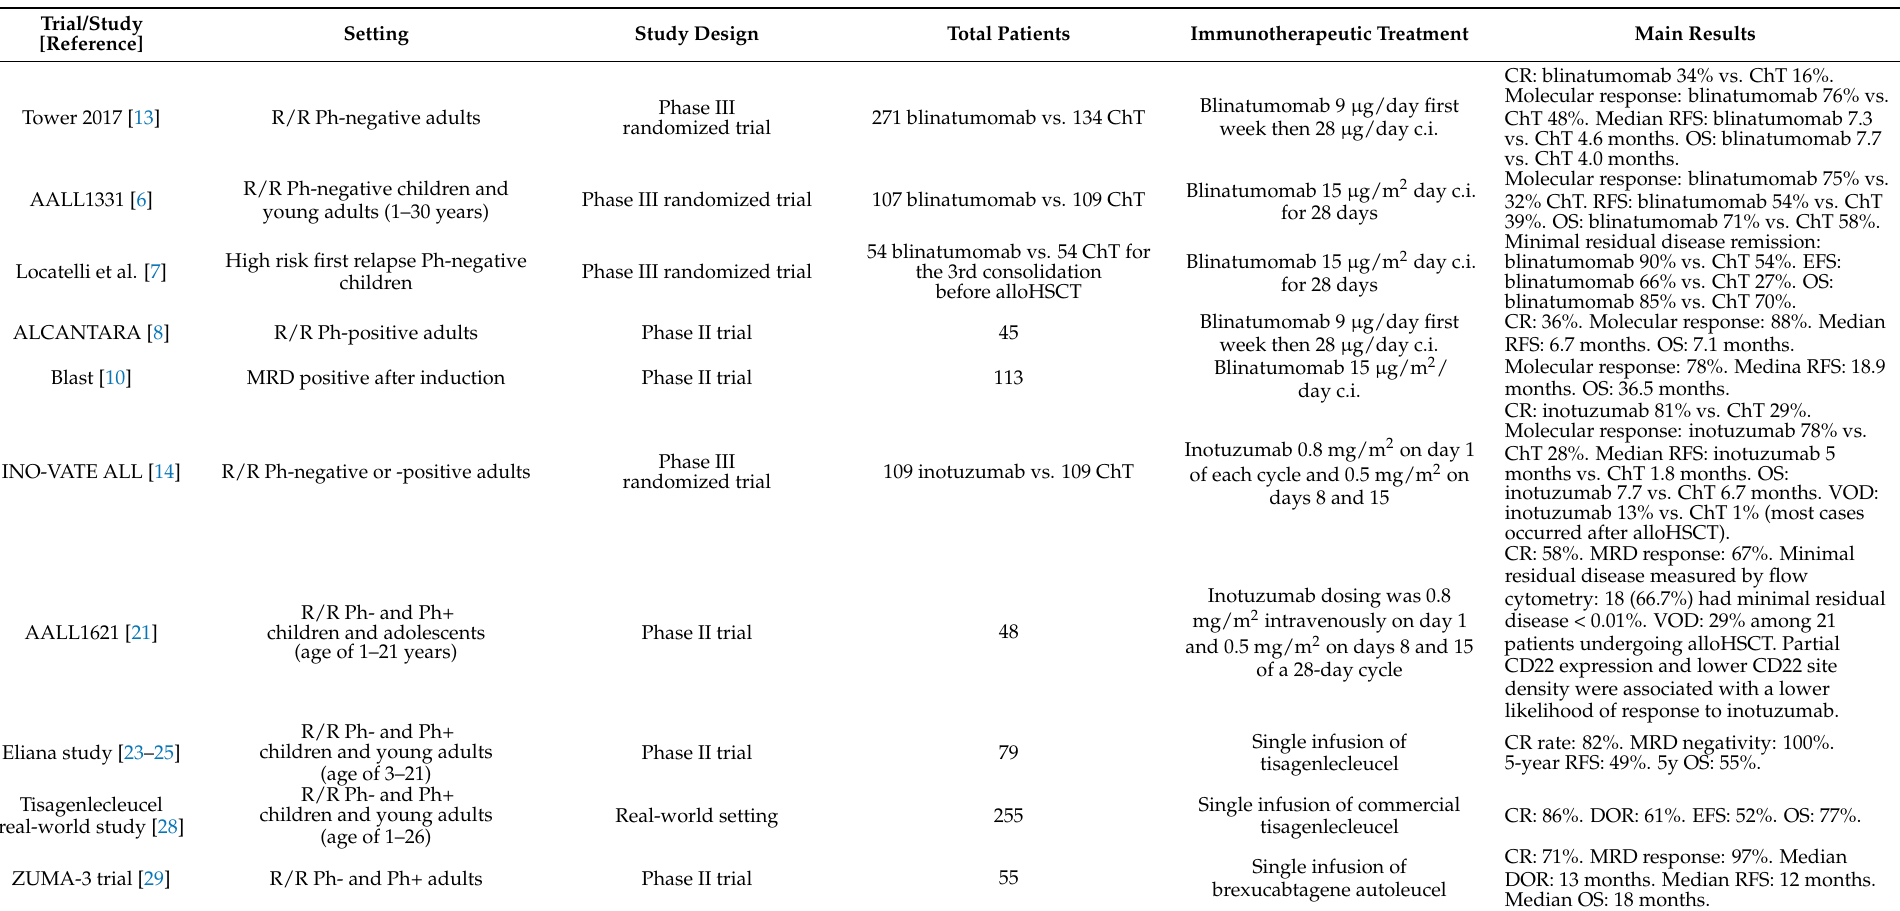
Table 1. Summary of the main clinical studies on the immunotherapies approved for treating R/R BCP-ALL (blinatumomab, inotuzumab, tisagenlecleucel, and brexucabtagene